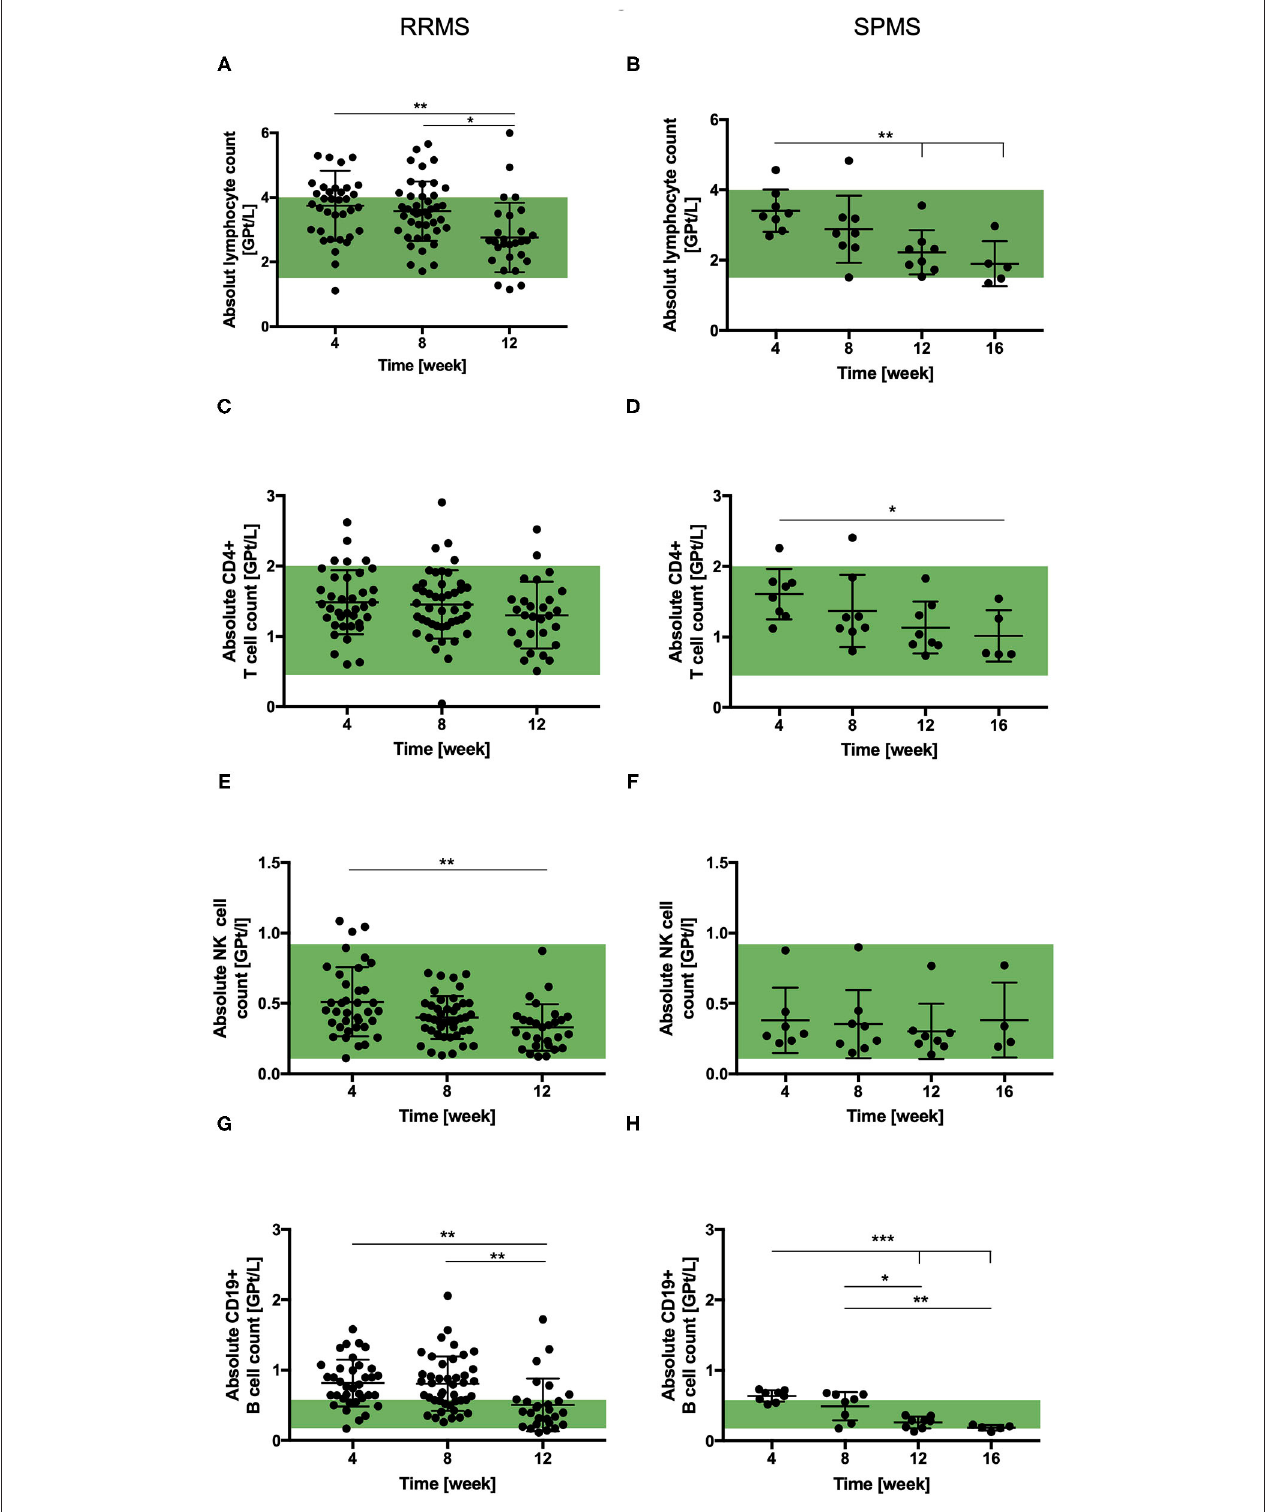
FIGURE 2 | Total lymphocyte and lymphocyte subset count in RRMS ( n = 50) and SPMS ( n = 9) patients after the cessation of NAT therapy. Mean absolute cell count ± SD of lymphocytes (A,B) , CD4 + T-cells (C,D) , NK cells (E,F) and CD19 + B-cells (G,H) are presented for RRMS (left) up to 12 weeks and for SPMS (right) patients up to 16 weeks after the cessation of NAT treatment. Reference range is green. Data were analyzed by generalized linear mixed models for repeated measures. Asterisks indicate a statistically significant difference (* p < 0.05, ** p < 0.01, *** p < 0.001).